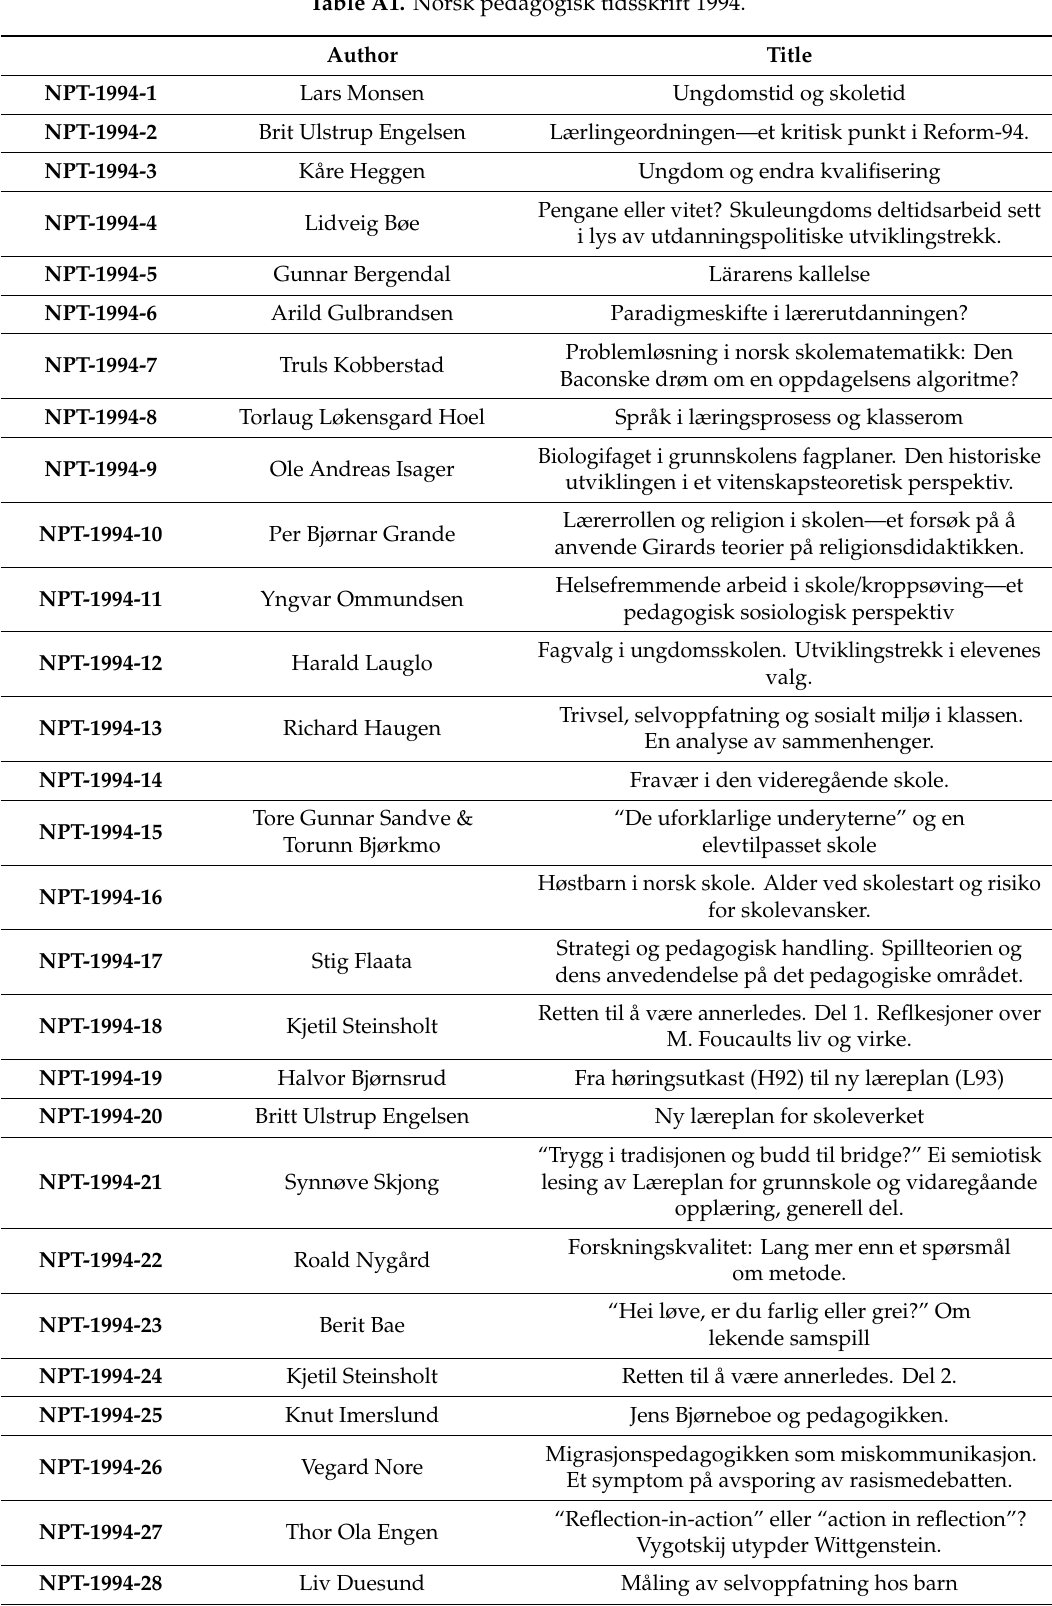
Table A1. Norsk pedagogisk tidsskrift